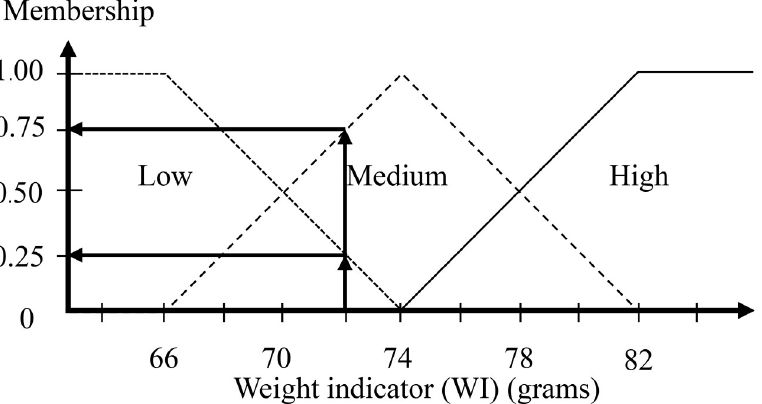
Fig 12. Input of the weight indicator is 72